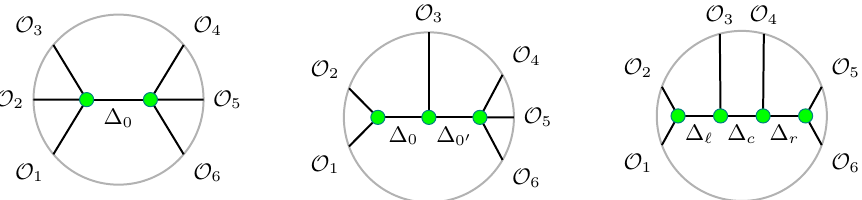
Figure 6. Inequivalent six-point tree-level diagrams which do not admit a direct channel CBD in the conformal basis of the OPE channel six-point block (instead, they do so in the comb channel).